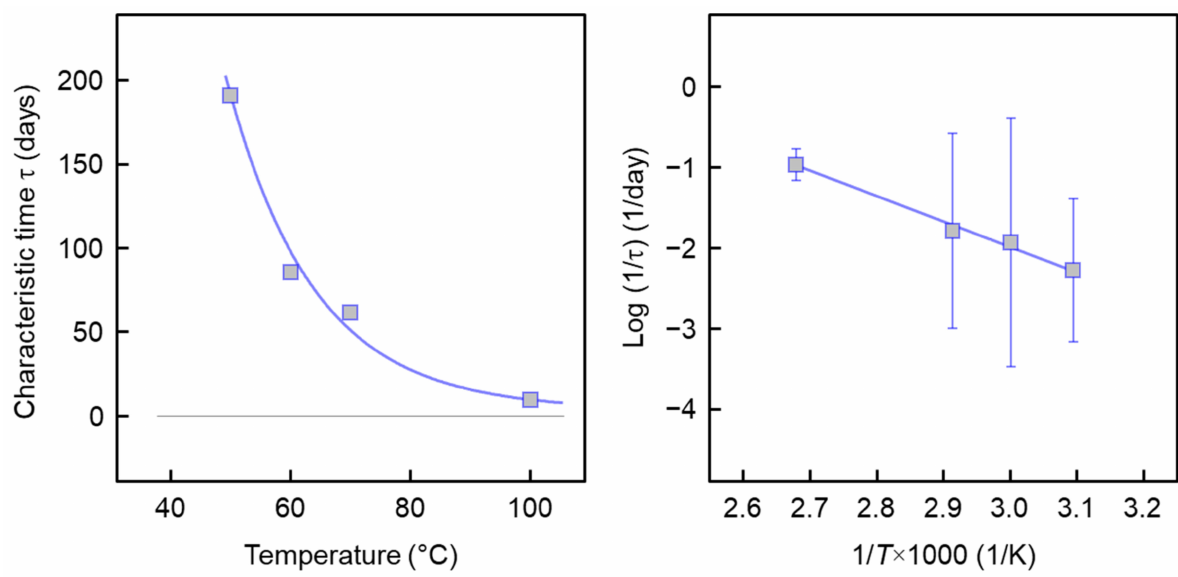
Figure 12. Characteristic repellent release time of strands with a diameter of about 2 mm of PLLA/IR3535 extrudates initially containing 18 m% IR3535 as a function of temperature ( left ), and logarithm of the inverse of the characteristic time, log (1/ τ ), as a function of inverse release temperature (1/ T ) ( right ). Each data point represents the average of two measurements; the error bars are smaller than the size of the symbols, and are therefore not